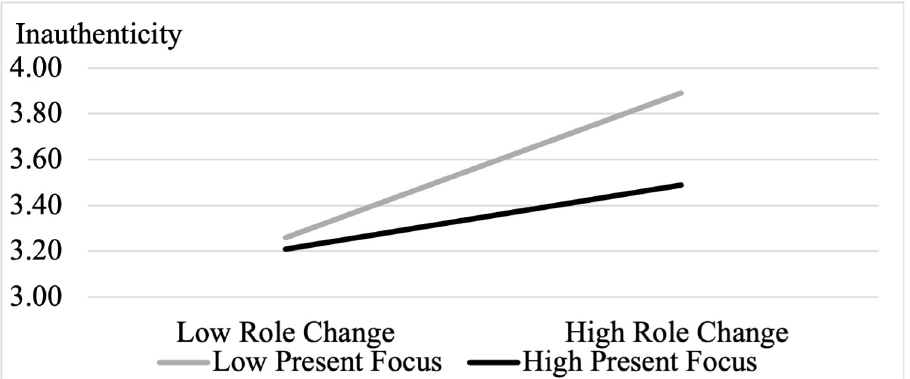
Fig 3. Interaction of role change and present-focus on inauthenticity in Study